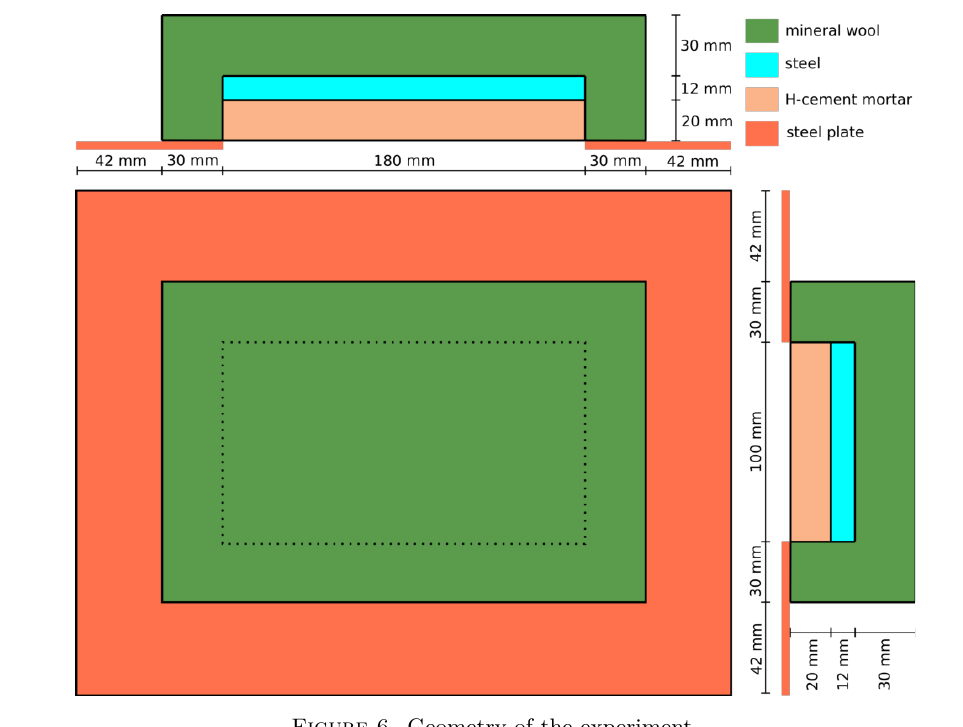
Figure 6. Geometry of the experiment.